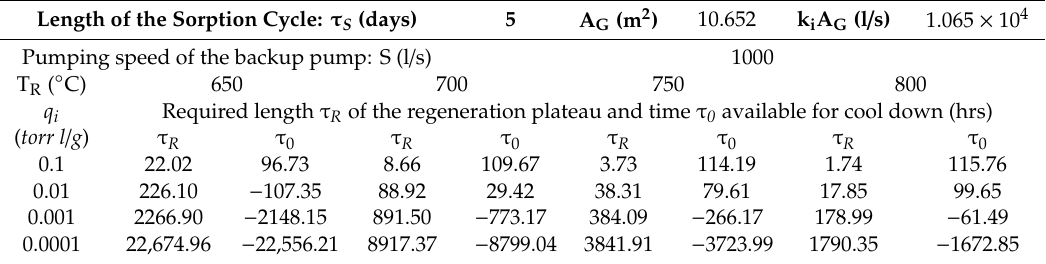
Table 8. Regeneration and cool-down times of ST101 for S = 1000 l / s and τ S = 5